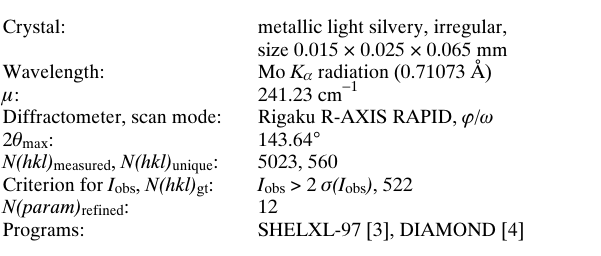
Table 1. Data collection and